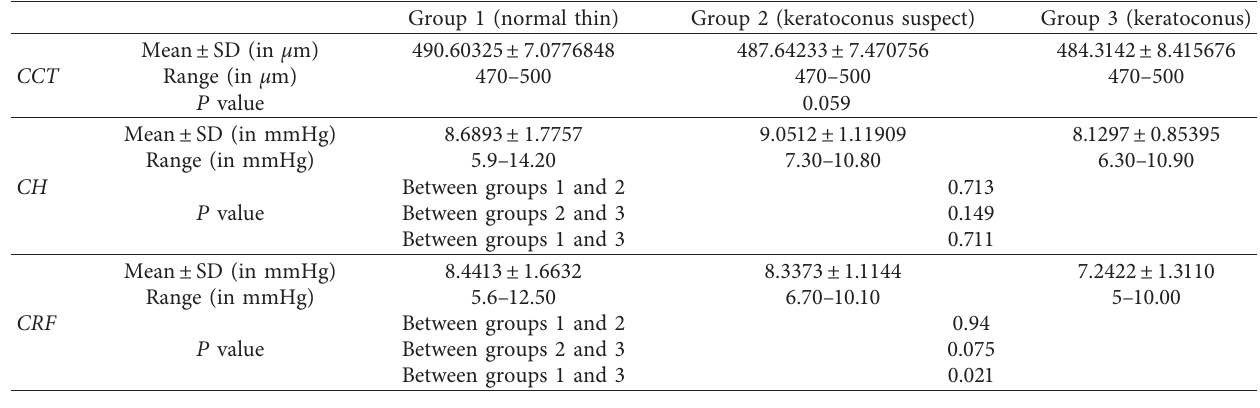
Table 3: Central corneal thickness (CCT) and the corneal hysteresis (CH) and the corneal resistance factor in three groups.